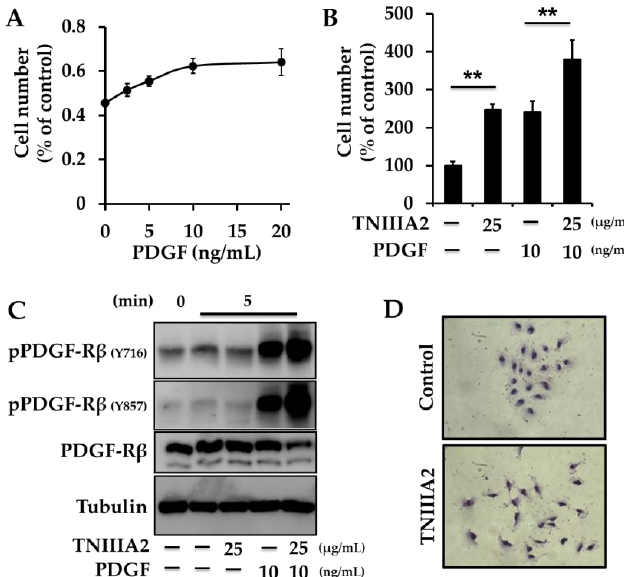
Figure 3. Peptide TNIIIA2 induces the hyperproliferation and disseminative migration of glioma/glioblastoma multiforme (GBM) cells. ( A , B ) Effect of peptide TNIIIA2 on PDGF-dependent proliferation of glioma cells. Rat glioma C6 cells were stimulated with PDGF in the presence or absence of peptide TNIIIA2 for 2 days. Cells were subjected to WST-8 assay. Each point represents the mean ± SD, ** p < 0.01. ( C ) C6 cells on fibronectin substrate were stimulated with peptide TNIIIA2, PDGF, or their combination, for the indicated period. Cell lysates were subjected to Western blotting analysis. ( D ) Scattering assay was performed. Cobblestone-like cell clusters were developed by culturing human GBM U251 cells on fibronectin substrate. Cells were treated in the presence or absence of TNIIIA2 (25 μg/mL) for 12 h.